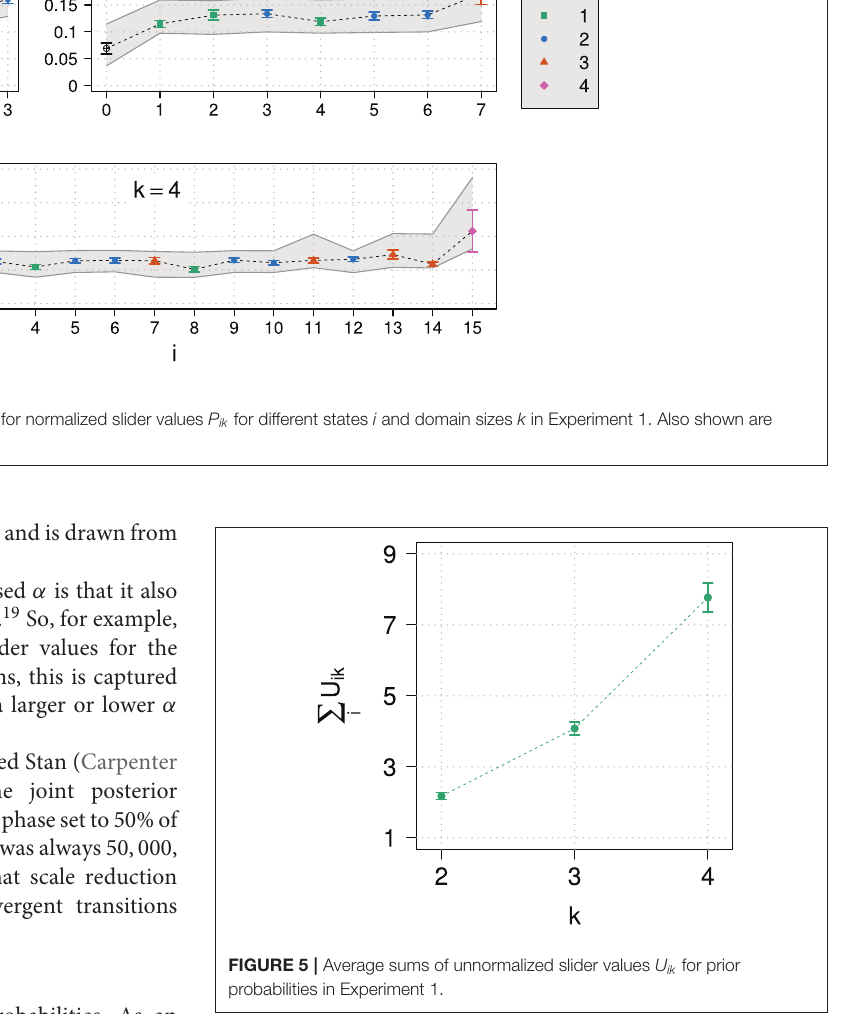
FIGURE 5 | Average sums of unnormalized slider values U ik for prior probabilities in Experiment 1.